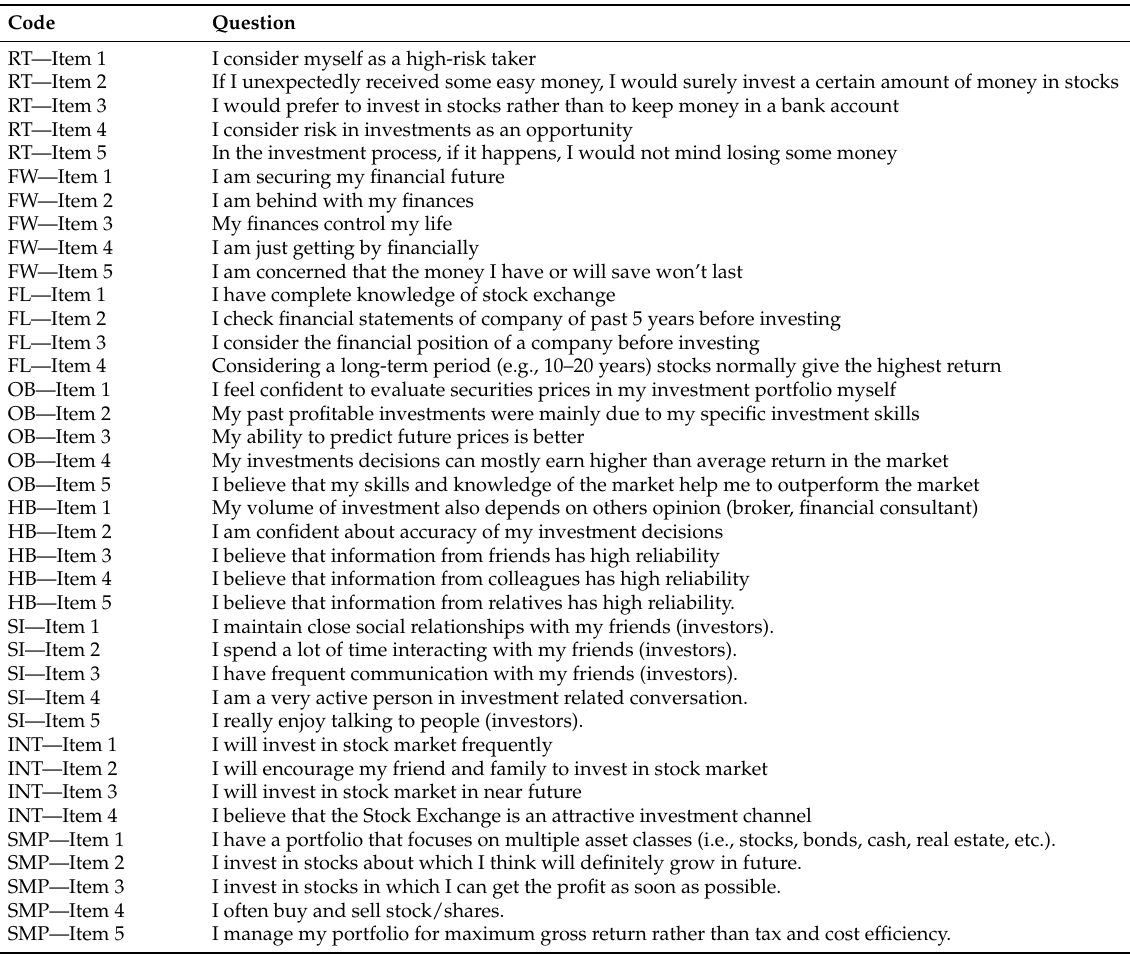
Table A1. Survey